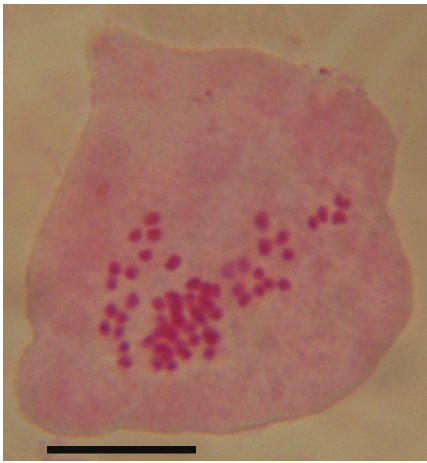
Figure 3. Asyneuma trichocalycinum (Ten.) K.Malý, 2 n = 64. Scale bar 10